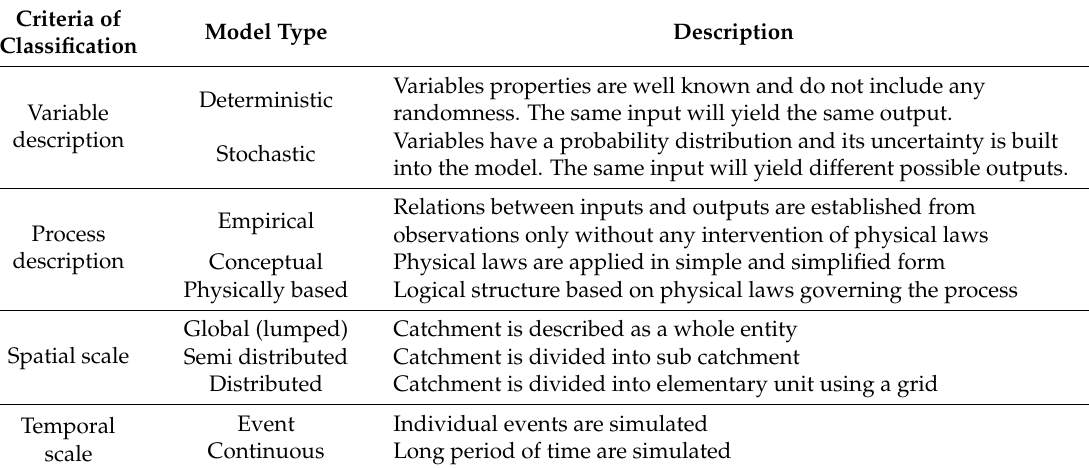
Table 2. General classification of stormwater quality models based on different criteria.